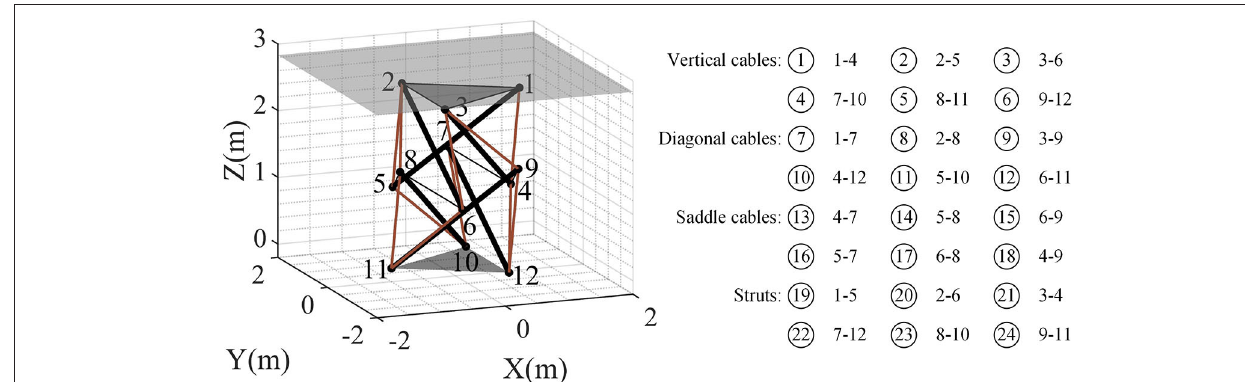
FIGURE 1 | Flowchart of the solving method.